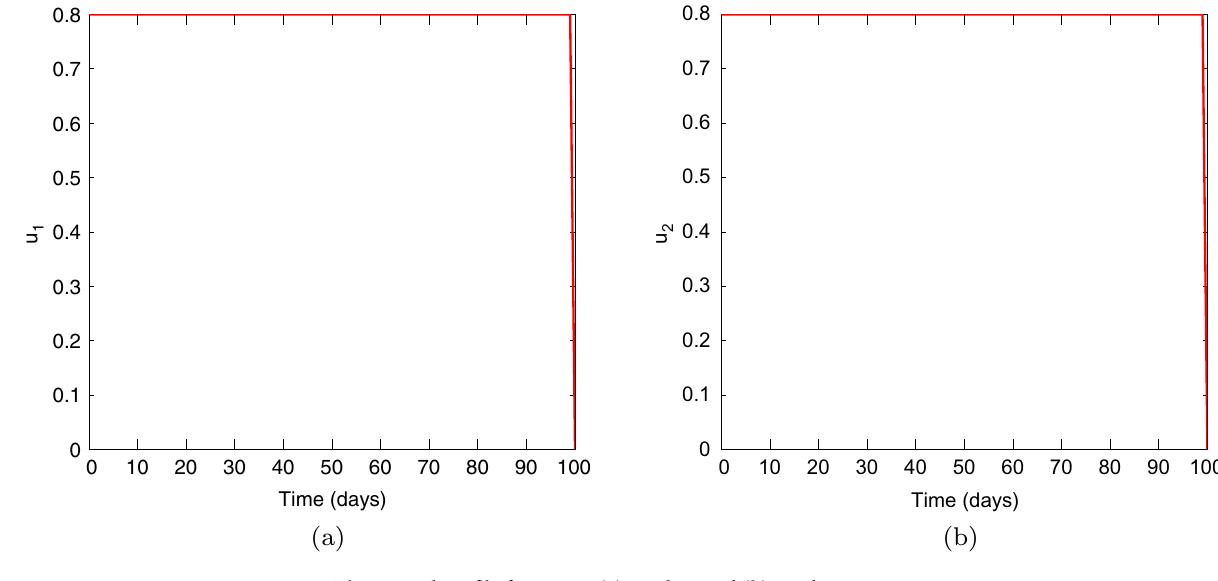
Figure 11. The control profile for case 1: ( a ) Patch 1; and ( b ) Patch 2.